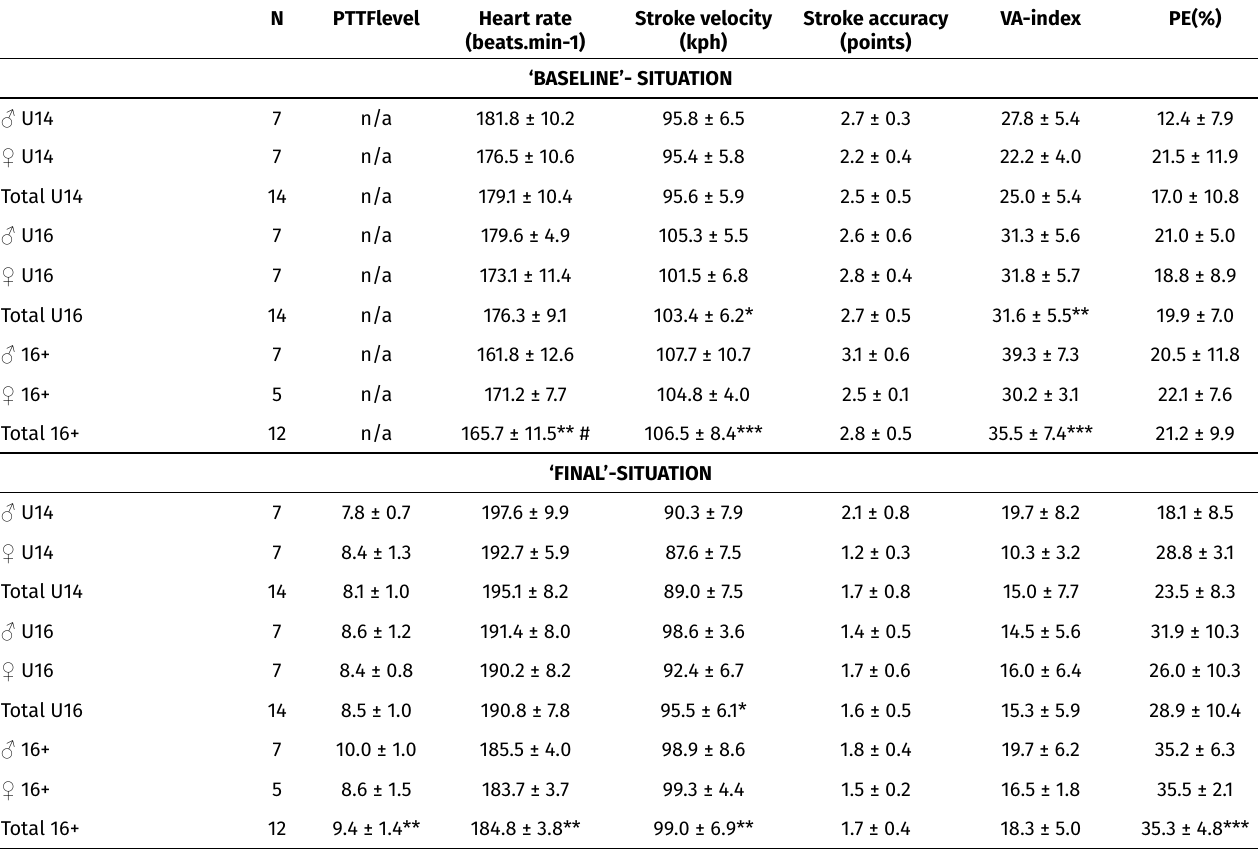
Table 2. Outcome variables for both intensity situations of the PTTF-test divided by age category and gender N PTTFlevel Heart rate